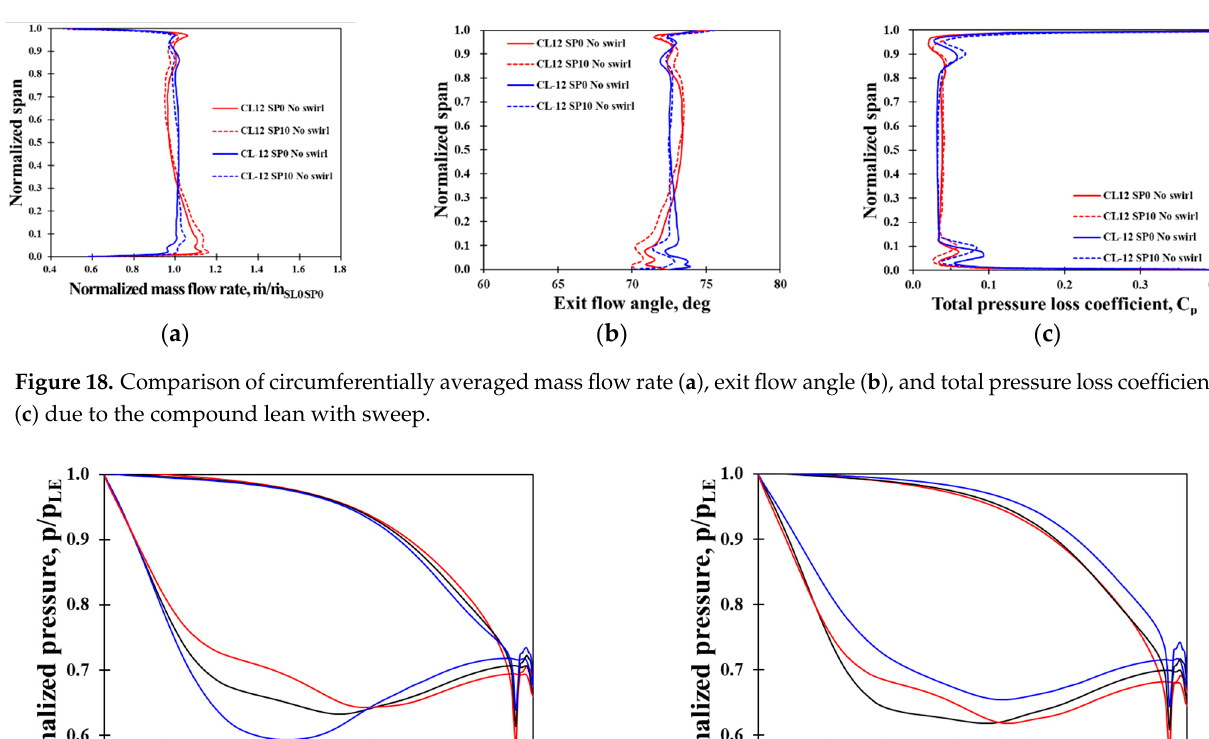
Figure 17. Comparison of circumferentially averaged mass flow rate ( a ), exit flow angle ( b ), and total pressure loss coeffi- cient ( c ) due to the straight lean with sweep.